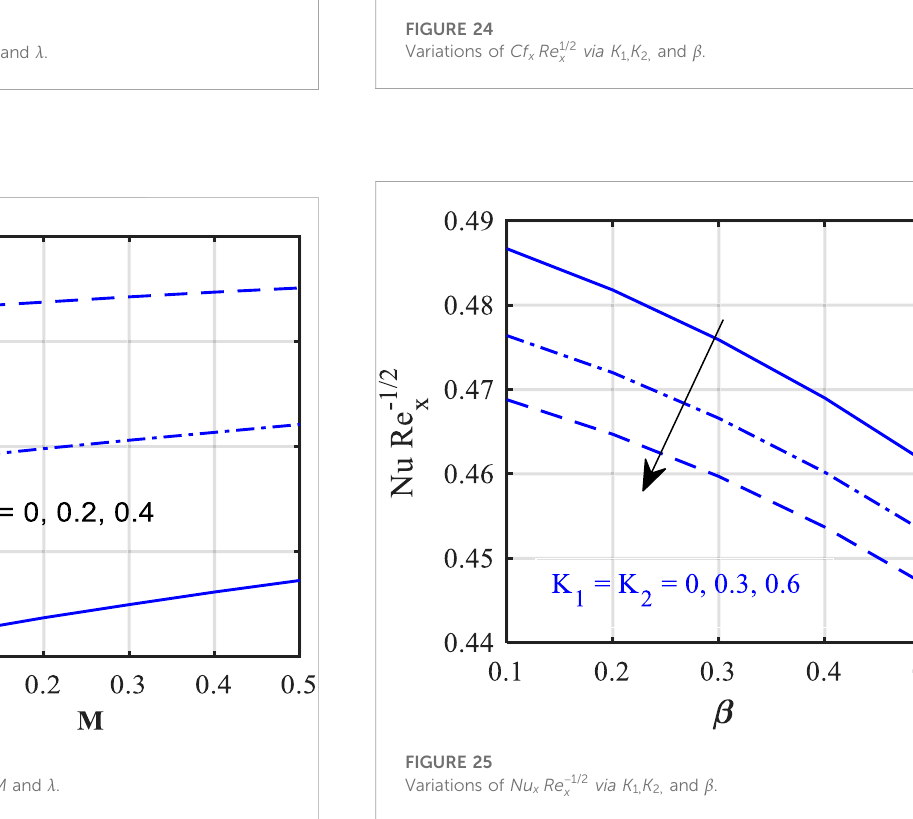
FIGURE 24 Variations of Cf x Re 1/2 x via K 1 , K 2 , and β .